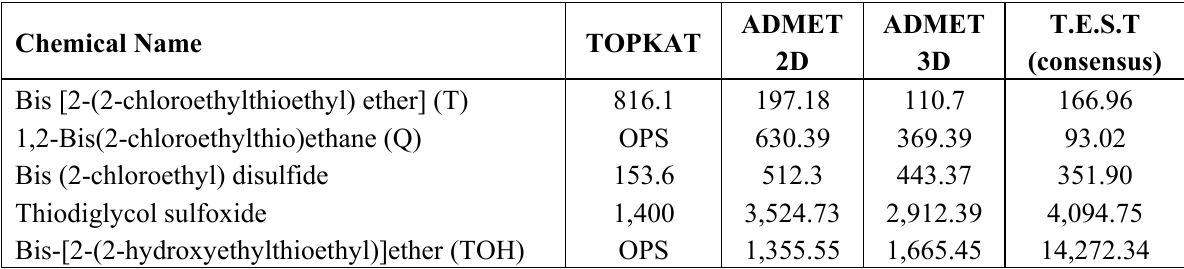
Table 3. Comparison of the estimated LD predictor and the T.E.S.T. model for chemicals that lack experimental